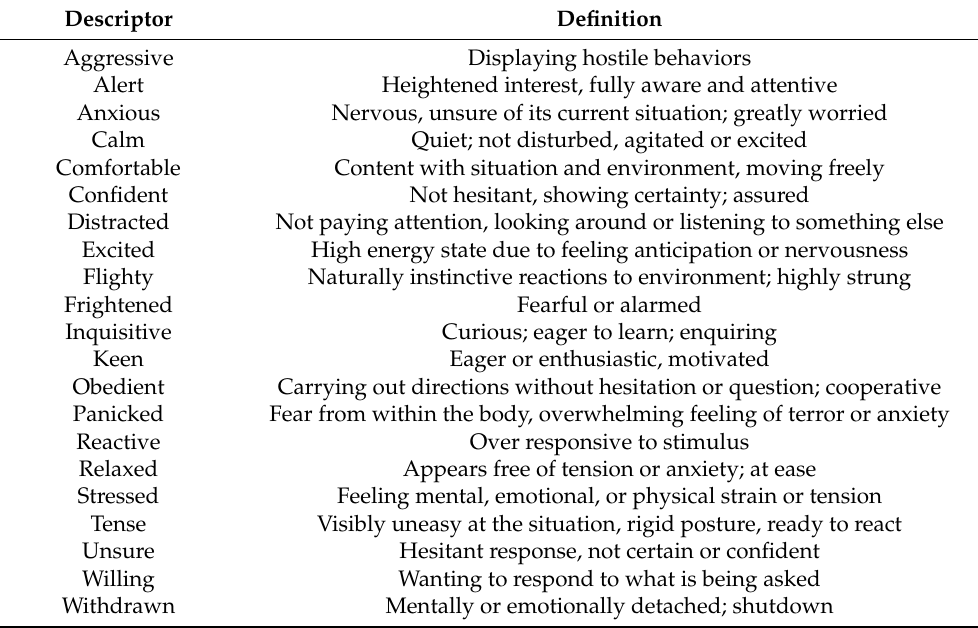
Table 2. Fixed term list developed by Free Choice Profiling mainly used terms. For each term, observers discussed and agreed on a brief description of the meaning.